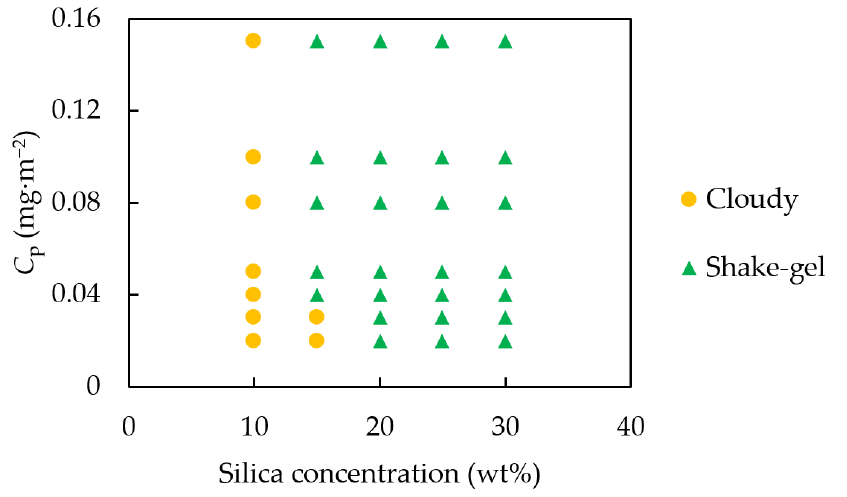
the distance between silica particles and observed the state of the silica-PEO suspension. The results are shown in Figure 2.